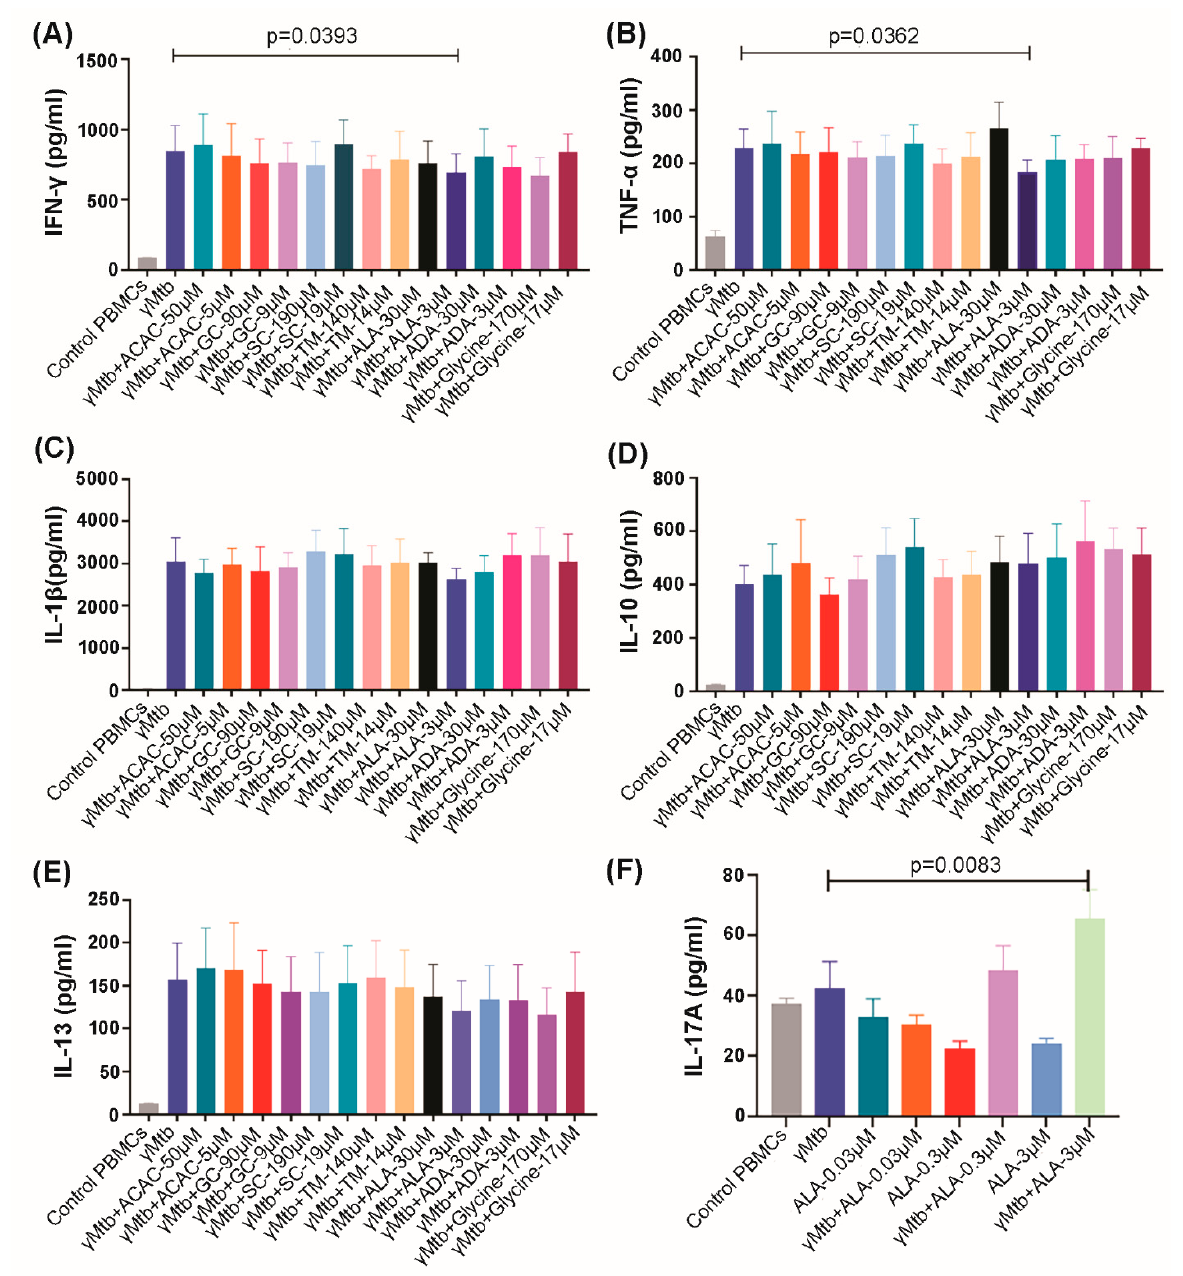
Figure 2. Effect of metabolites on cytokine production by PBMCs of LTBI+ donors. PBMCs of healthy LTBI+ donors were cultured with or without γ Mtb (10 µg/mL) and in the presence or absence of different concentrations of ALA and other metabolites, as mentioned in the Methods section. After 72 h, culture supernatants were collected, and cytokine levels were measured using ELISA: ( A ) IFN- γ , ( B ) TNF- α , ( C ) IL-1 β , ( D ) IL-10, ( E ) IL-13, and ( F ) IL-17A. In ( A – E ), six donors were collected, while in ( F ), five donors were collected. Paired t -tests were used to compare the differences between untreated and treated PBMCs from the same samples. The mean values and SDs are shown, and the significant p values are shown ( p < 0.05).